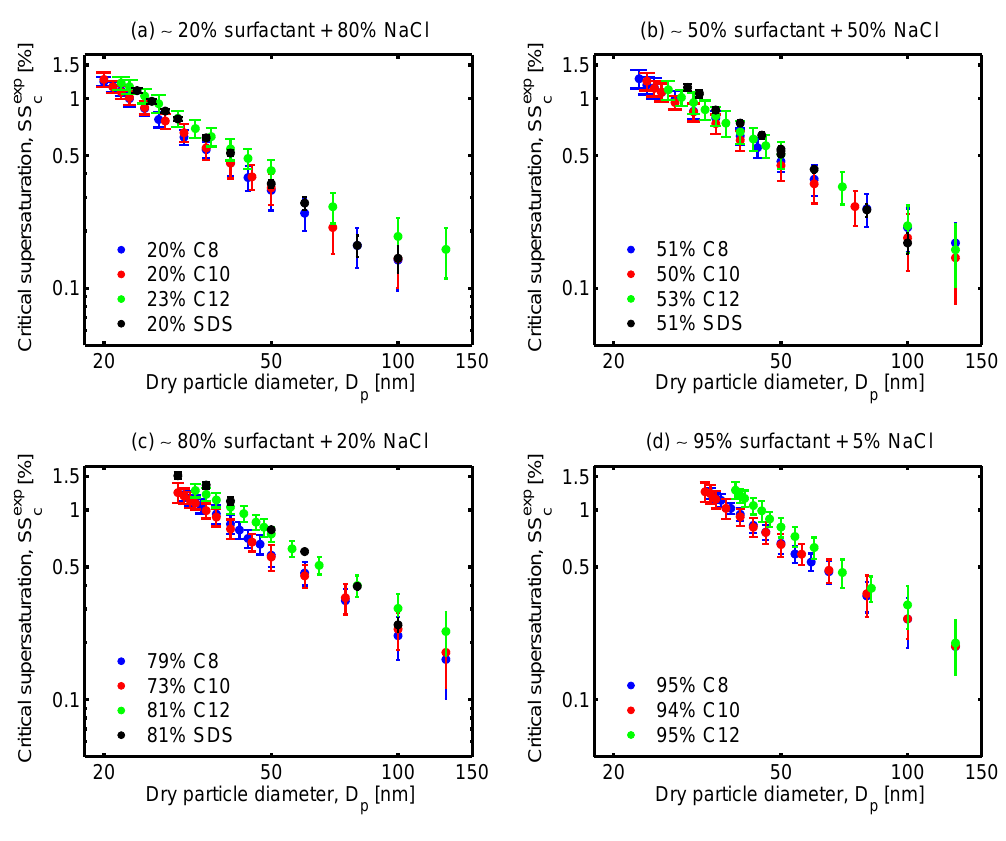
Fig. 1. Experimental critical supersaturations ( SS exp c [%]) as a function of dry particle diameter ( D p [nm]) for all dry particle compositions. Individual panels show results for approximate surfactant mass fractions ( W p, SFT ) of (a) 20%, (b) 50%, (c) 80% and (d)